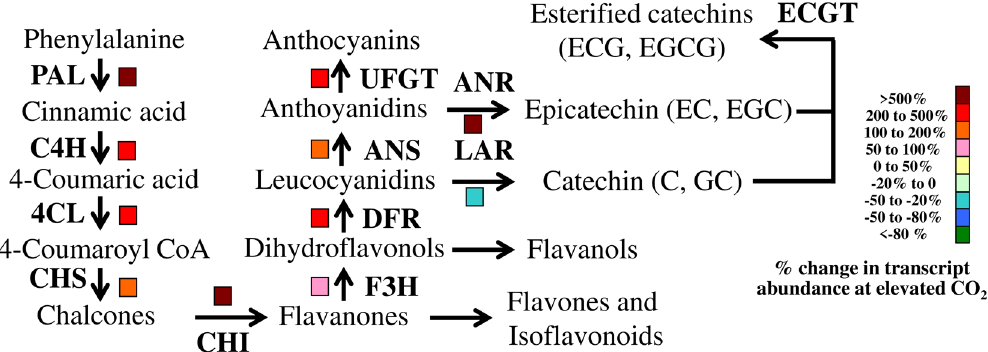
Figure 5. Transcript levels of catechins synthetic pathway-related genes in tea leaves as influenced by ambient (380 µ mol mol − 1 ) or elevated CO 2 concentration (800 µ mol mol − 1 ). Leaf samples were harvested at 24 days following exposure of tea seedlings to different atmospheric CO 2 concentrations. Expression levels of genes were analyzed by qPCR using gene-specific primer pairs (Supplementary Table S1). Four biological replicates were used for qPCR